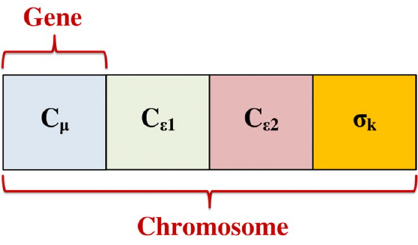
Fig. 8 Flowchart of GA Fig. 9 Chromosome structure for the